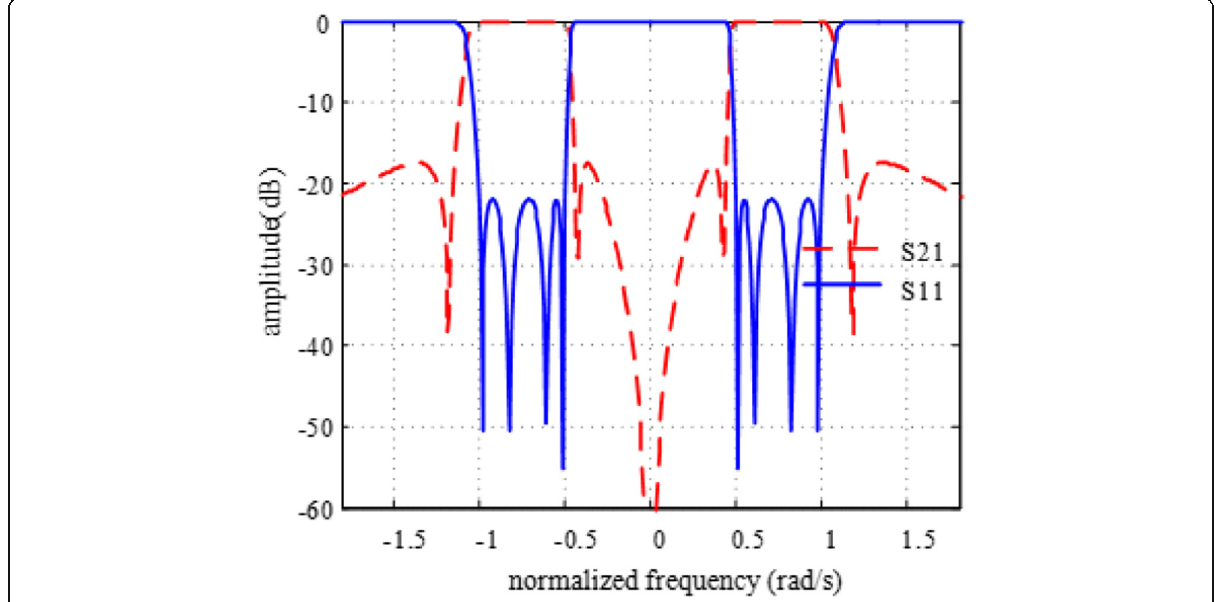
Fig. 4 Normalized S parameters response curve of dual-passband